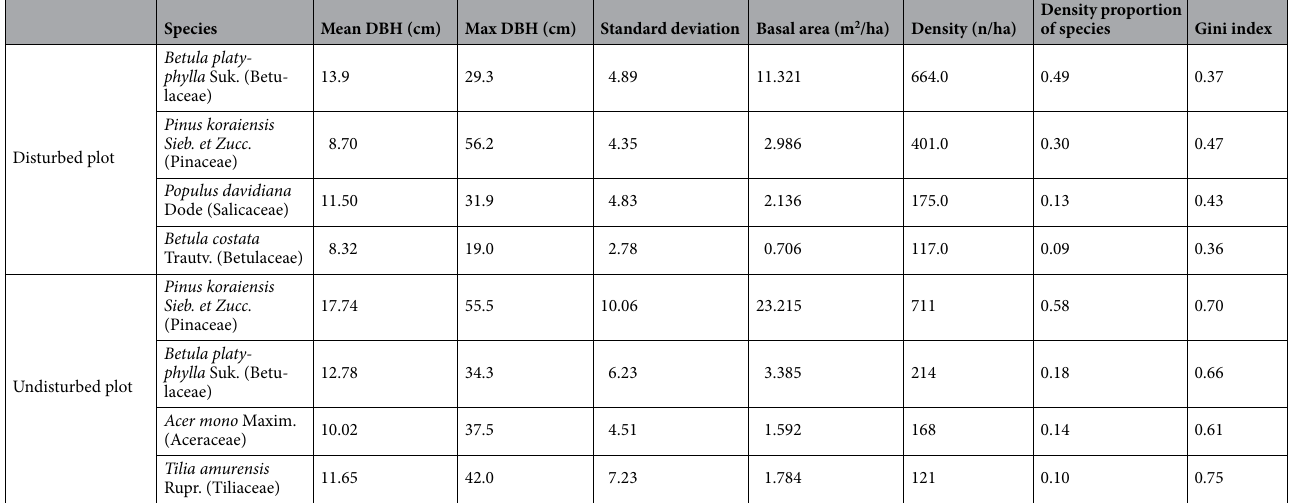
Table 1. Structural characteristics for species in the entire